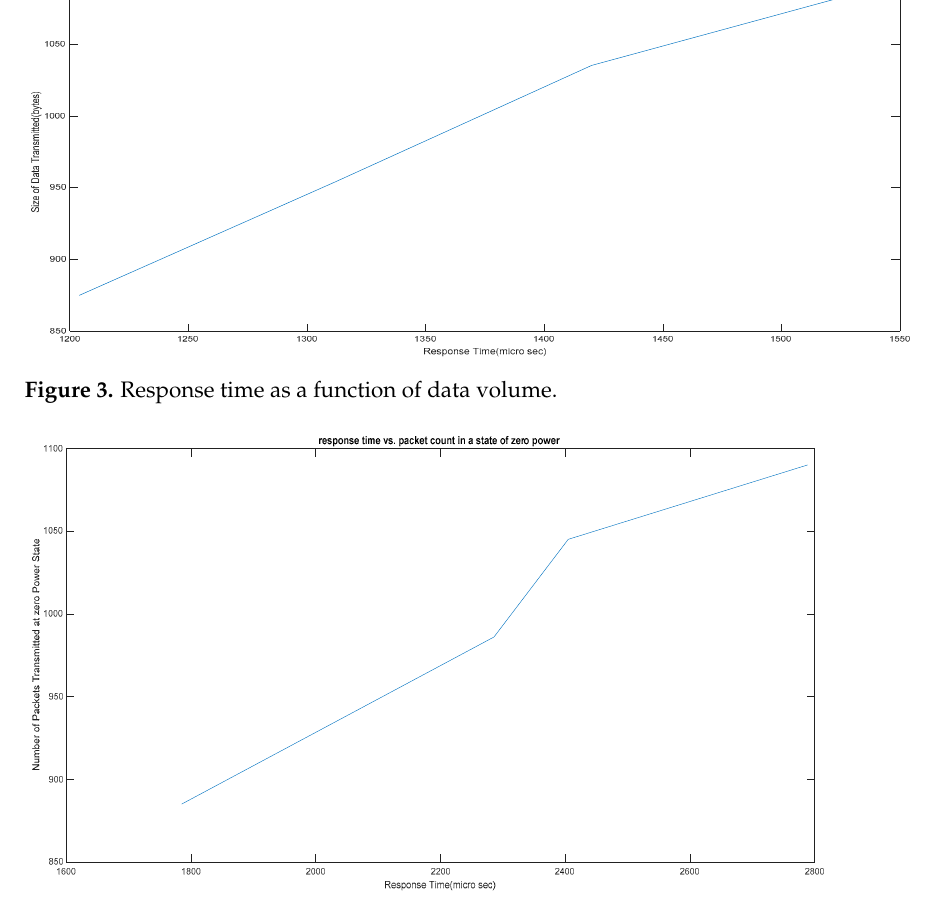
Figure 4. A graph of response time vs. packet count in a state of zero power.